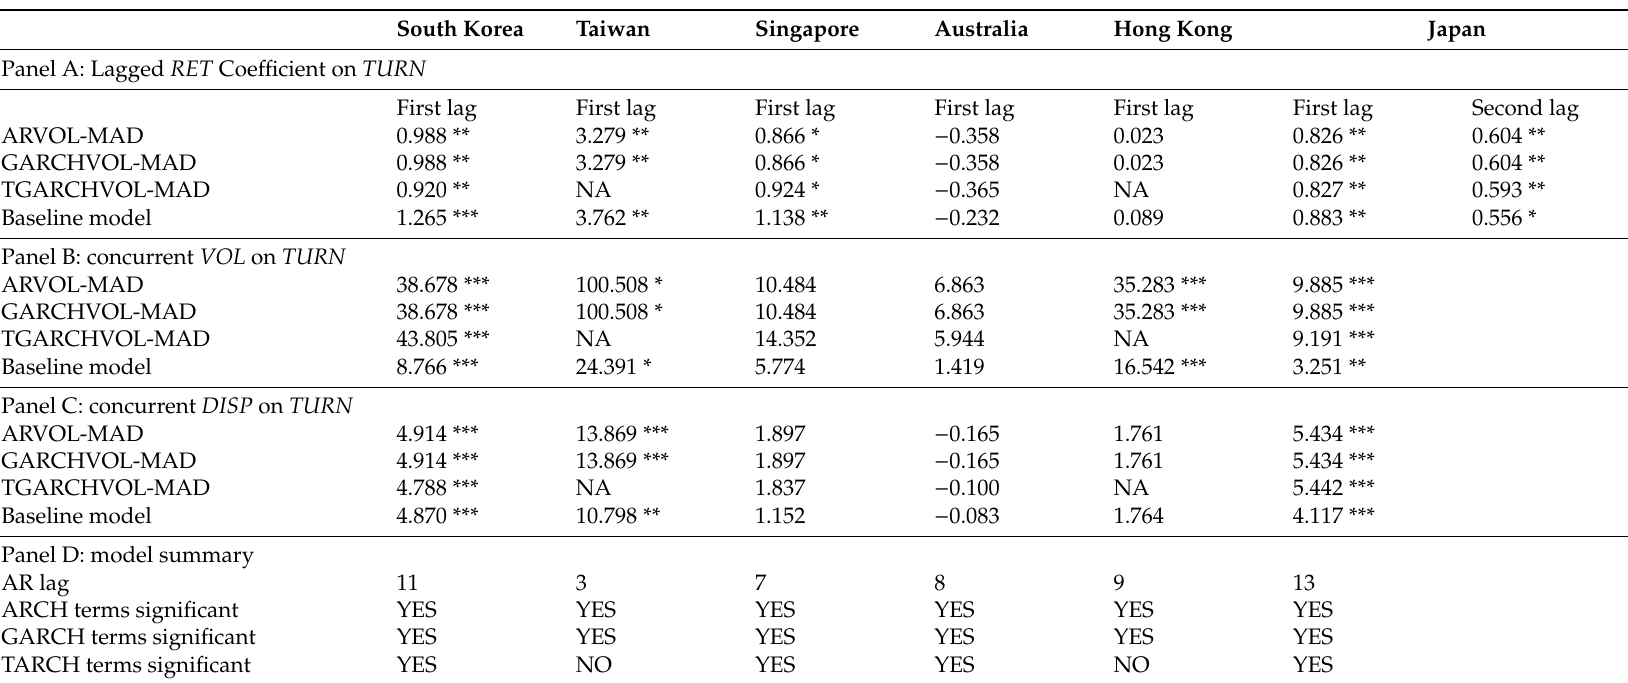
Table 6. VAR full-sample results in di ff erent measures of market volatility and dispersion. South Korea Taiwan Singapore Australia Hong Kong